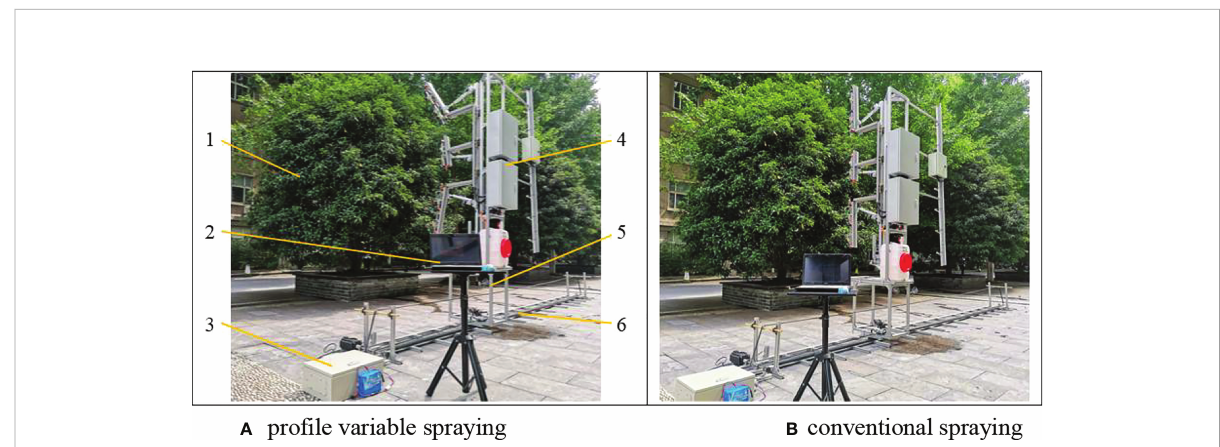
Figure 4 was a fi eld diagram of an outdoor spray test.